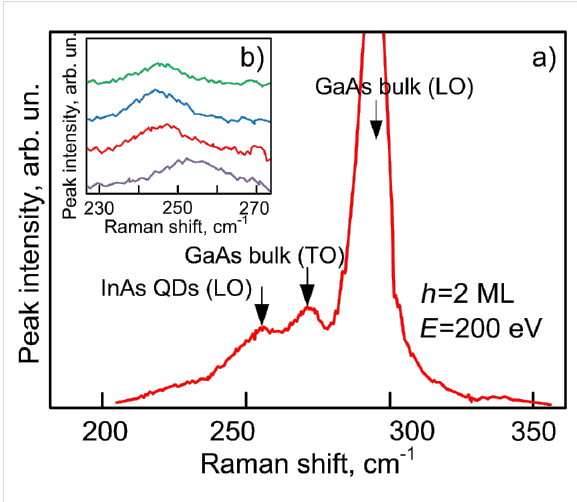
Figure 6: Raman scattering spectra of samples obtained at different ion energies.